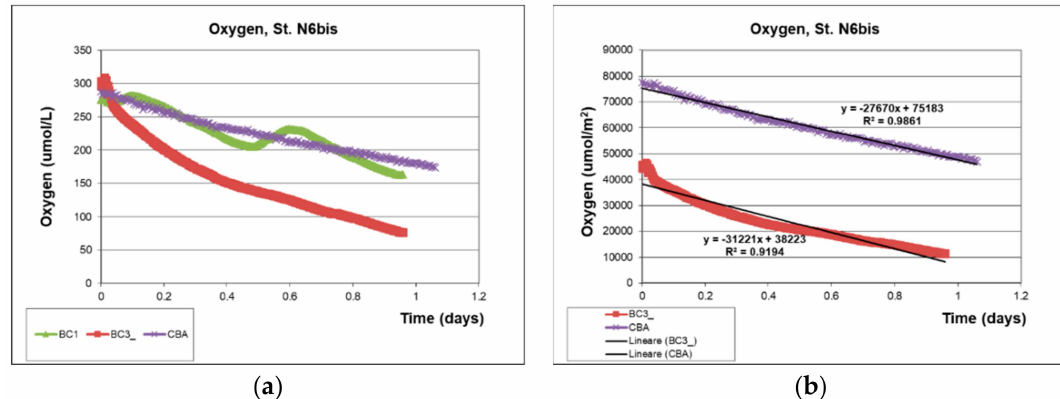
Figure 18. ( a ) Oxygen concentrations measured in the CBA and in two benthic chambers (BC1 and BC3) of the Amerigo Lander at the same site, a mud bottom sediment rich in fresh organic matter (Po River Prodelta); ( b ) multiplication of the oxygen concentrations by the height of the benthic chamber of the CBA and in BC3 against time (days) allows calculating the benthic fluxes (slope of the regression line (black line of Figure 18b)).